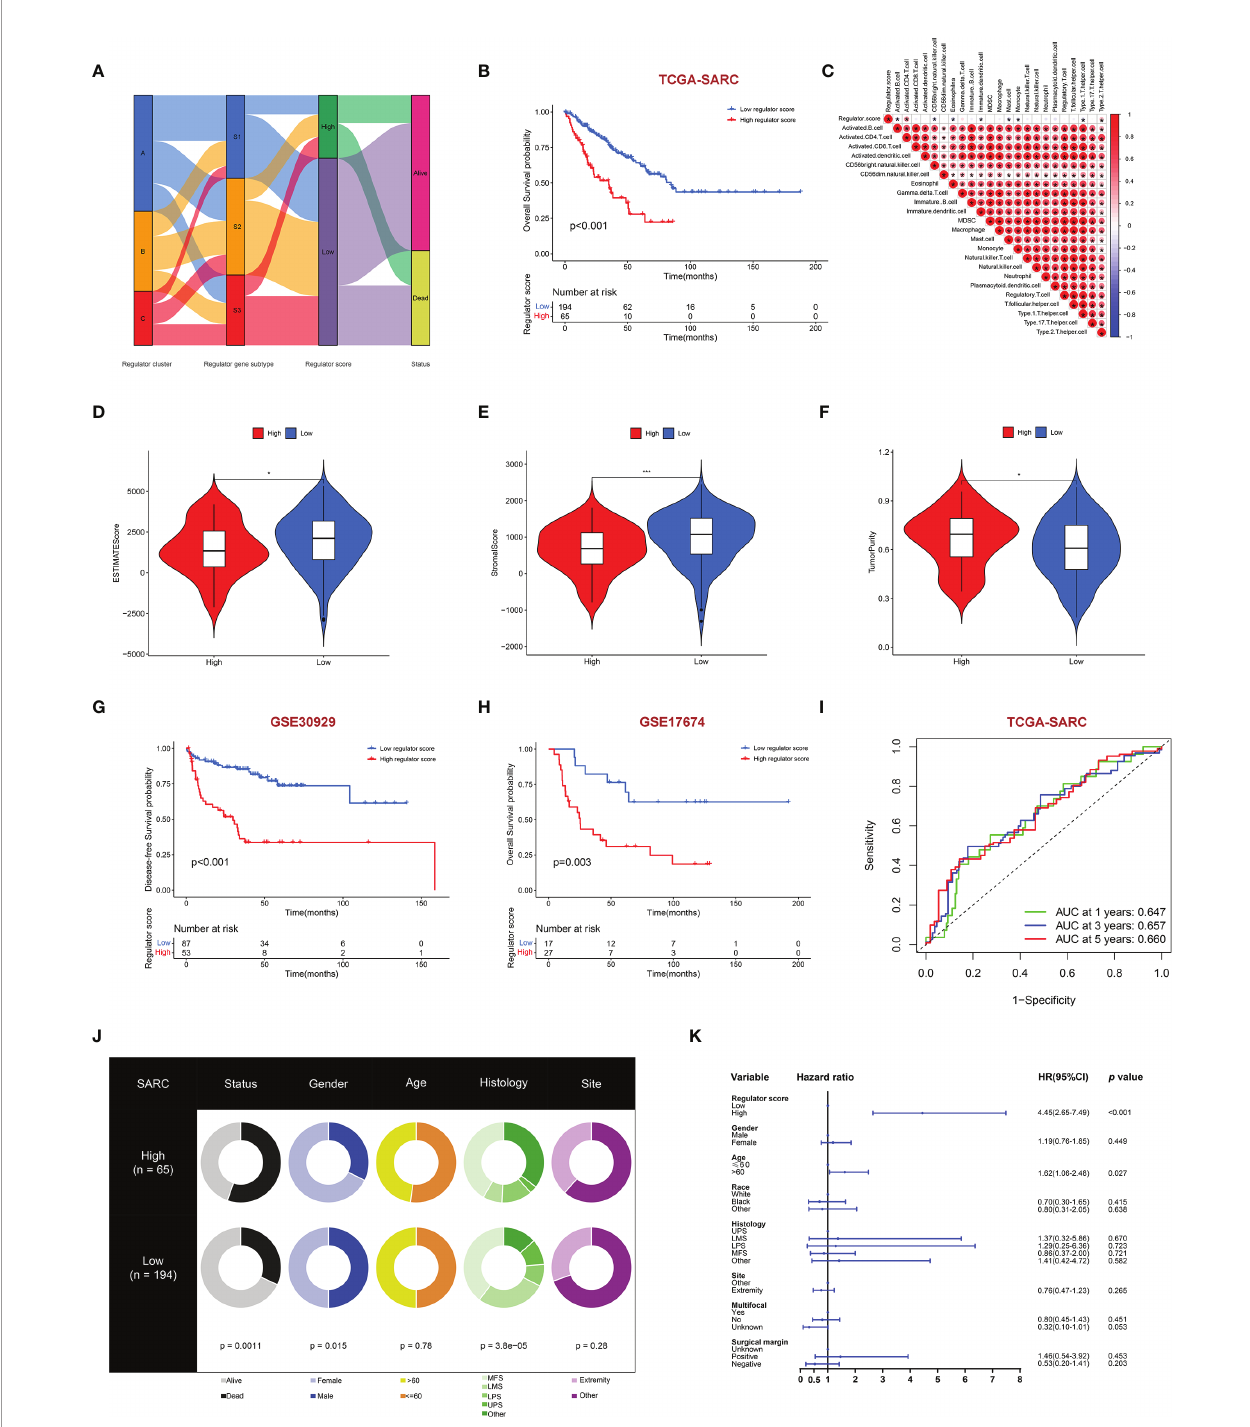
FIGURE 6 | Construction of regulator score and related clinical characteristics. (A) Alluvial diagram illustrating the association among regulator clusters, regulator gene subtypes, regulator score groups, and vital status. (B) The OS curve comparing survival of the TCGA-SARC cohort in low regulator score (blue) and high regulator score (red) groups. (C) Correlations between regulator score and immune cell in fi ltration by the Spearman correlation test. (D – F) Differences of ESTIMATES score (D) , stromal score (E) , and tumor purity (F) between high and low regulator score groups. (G, H) The DFS curve of GSE30928 (G) and the OS curve of GSE17674 (H) in low (blue) and high regulator score (red) groups. (I) Time-dependent ROC evaluating the predictive performance of the regulator score in the TCGA-SARC cohort. (J) Clinical characteristics between low and high regulator score groups in the TCGA-SARC cohort. (K) Multivariate Cox regression of clinical characteristics with regulator score. The horizontal line represents the 95% CI for each variable. The vertical dot line represents the HR of STS patients. *, 0.01 ≤ p < 0.05; **, 0.001 ≤ p < 0.01; ***, 0.0001 ≤ p <